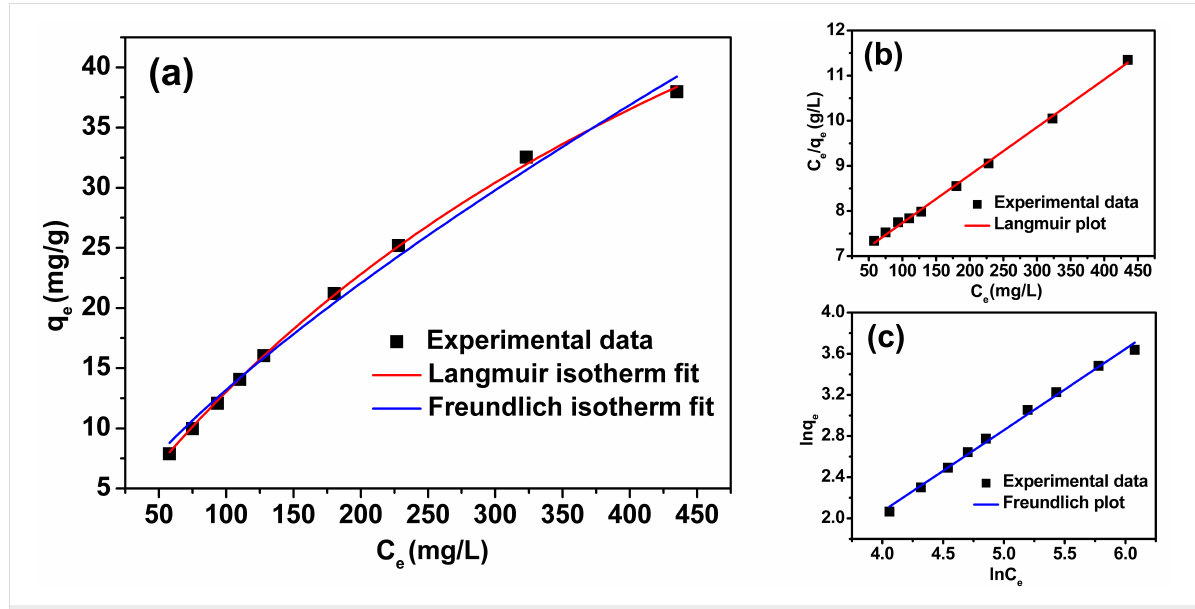
Figure 5: Adsorption isotherms (a) and the corresponding Langmuir plot (b) and Freundlich plot (c) for MB adsorption onto the electrospun nanofi- brous membranes.